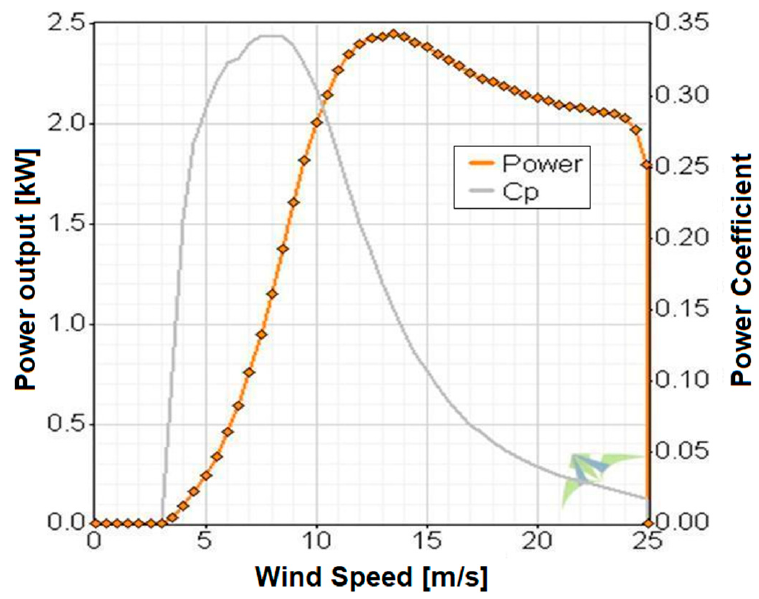
Figure 12. Power and Cp curves of the installed SWT. Source: Windographer ® .